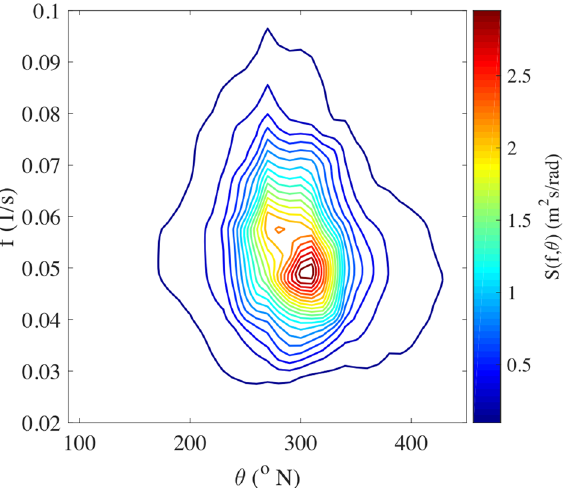
Figure 3. Directional spectrum computed using the Extended Maximum Likelihood Method. The largest peak at lower frequency corresponds to the swell propagating from North-West. The smaller peak is related to a wind sea in